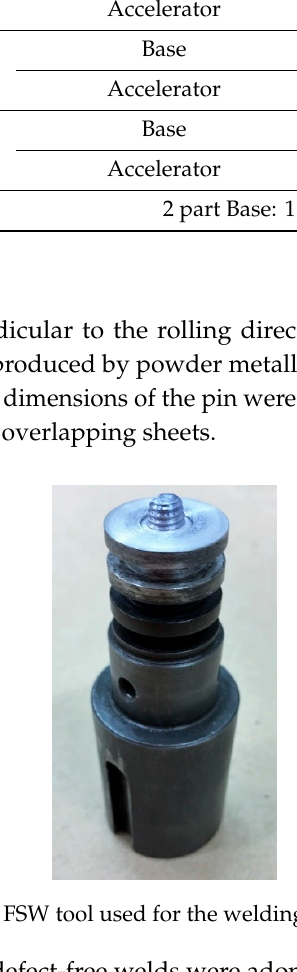
Table 3. Adhesive data.